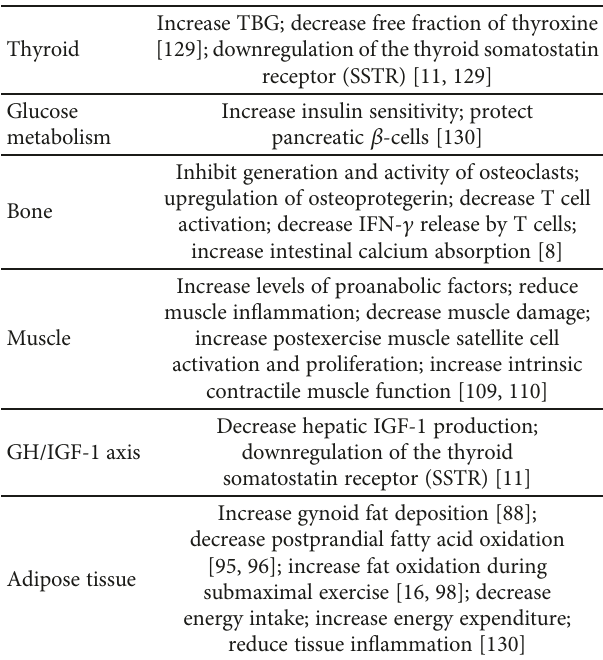
Table 1: Endocrine roles of estrogens in the human